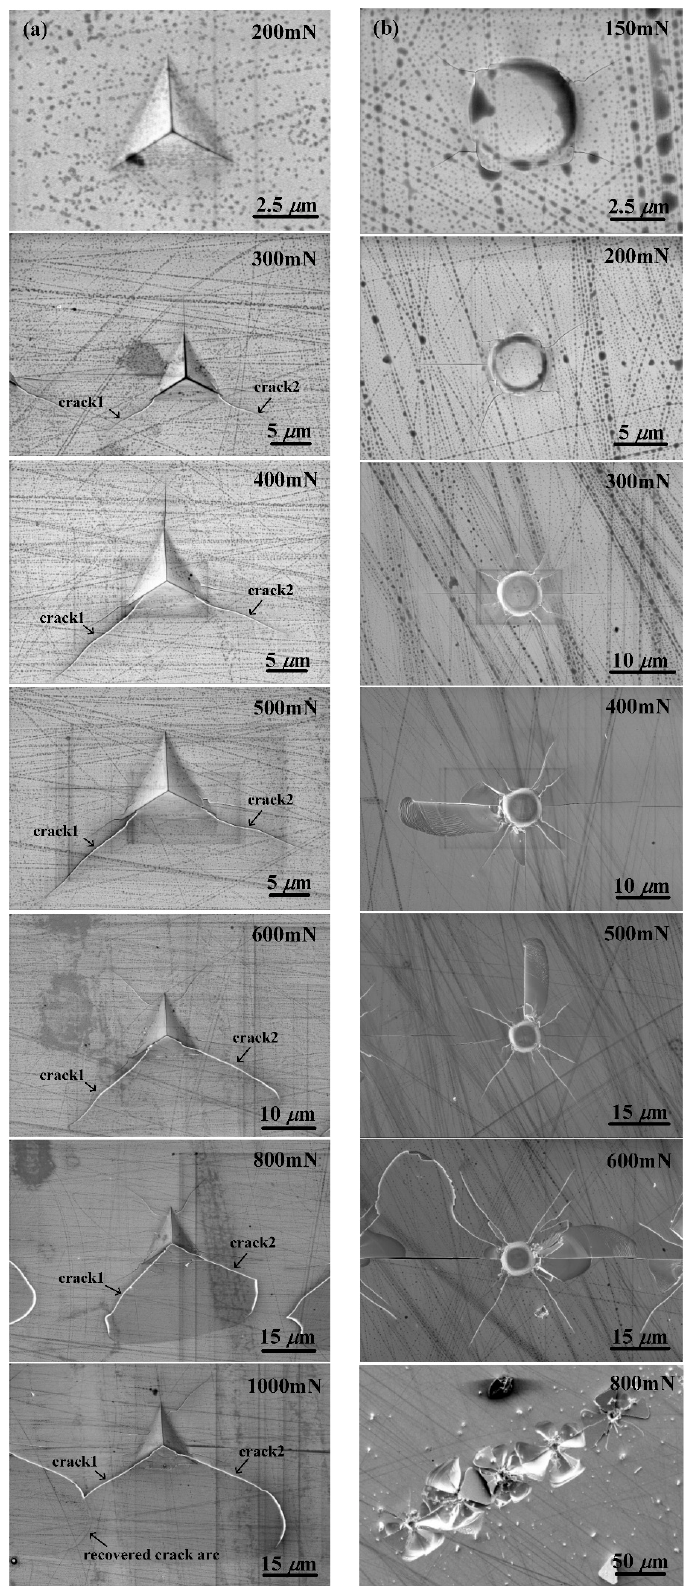
Figure 5. SEM images of typical indent imprints at different forces for ( a ) Berkovich indenter and ( b ) flat-tip indenter. “crack 1” and “crack 2” in ( a ) indicate two main cracks caused at different forces. “800mN” image in ( b ) gives the five crushed imprints at 800 mN under the flat-tip indentation.